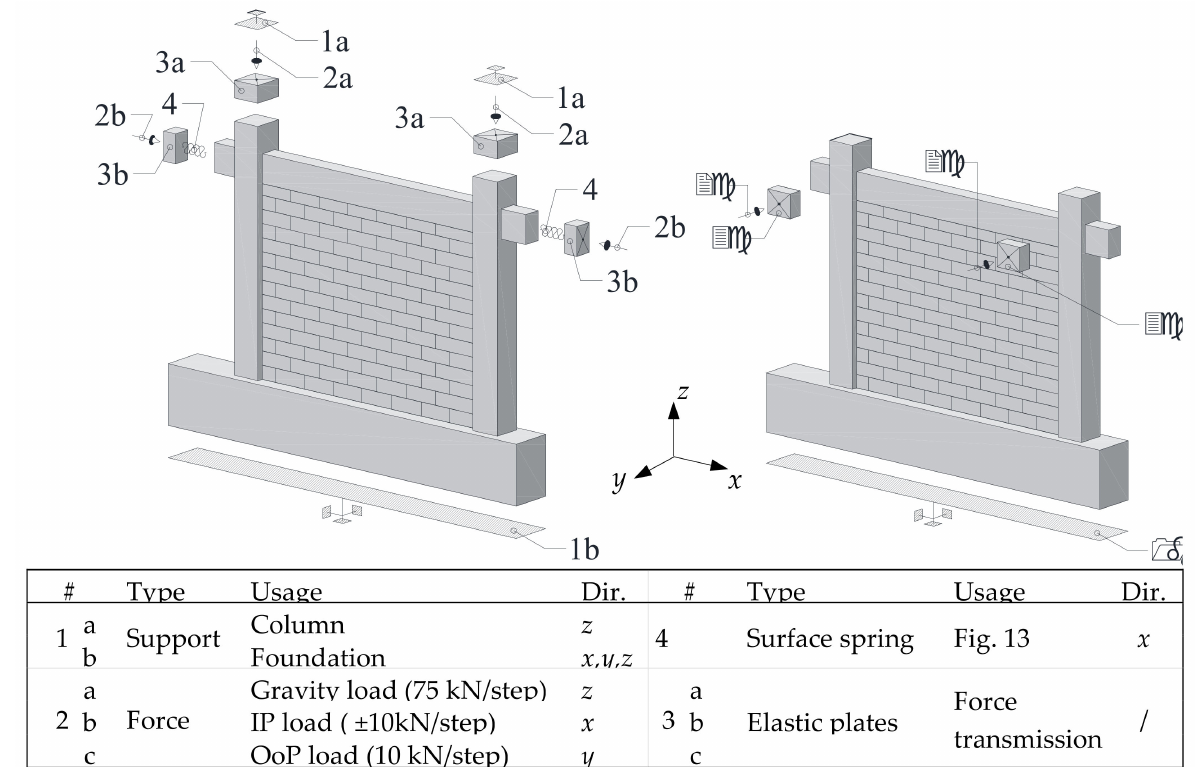
Figure 16. Boundary conditions of FI model (( left ) IP, ( right ) OoP loadings).